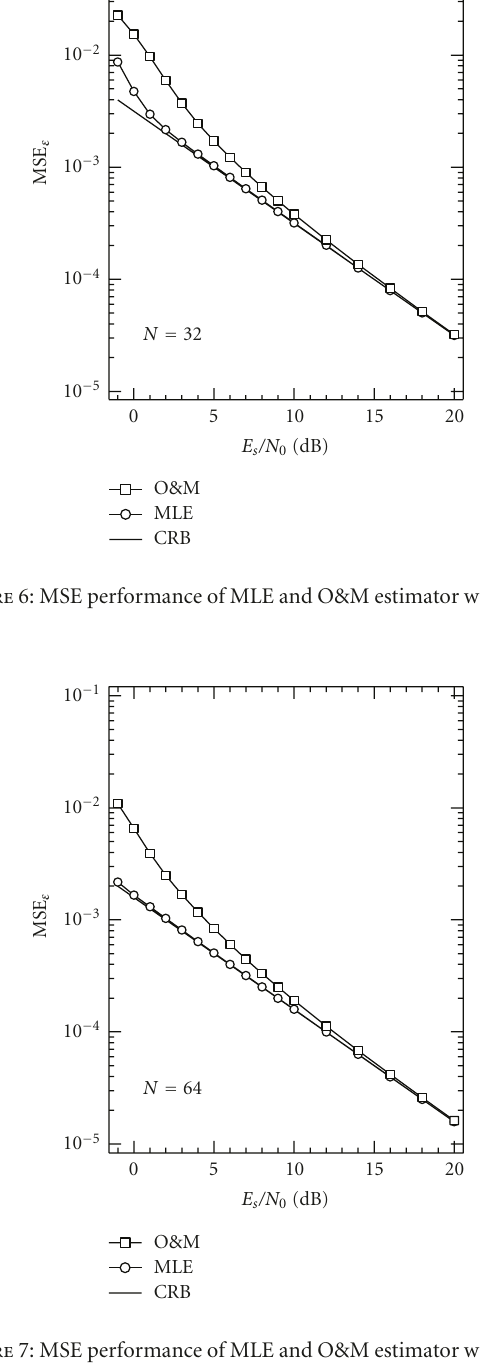
Figure 7: MSE performance of MLE and O&M estimator with N =